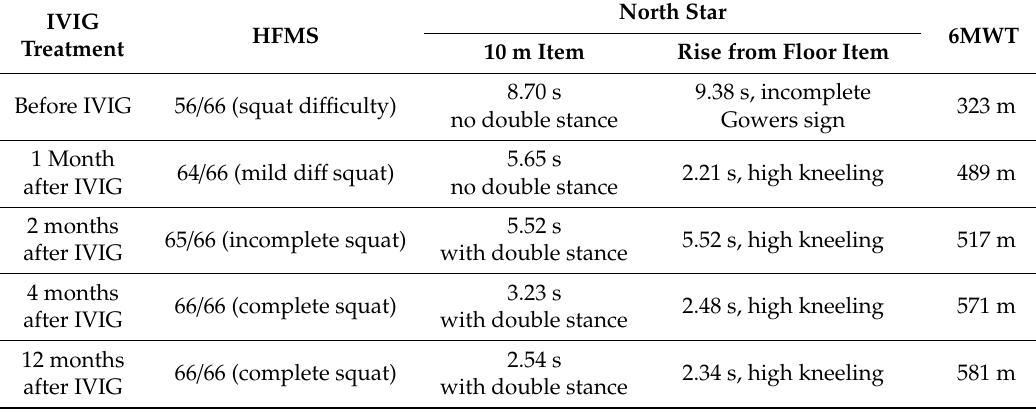
Table 2. Motor functional assessments before and after